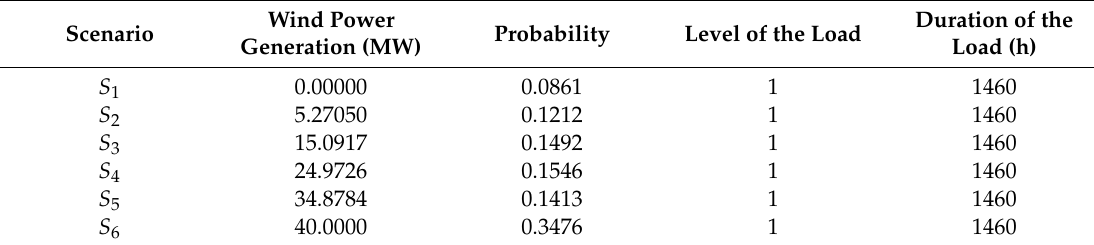
Table 12. Generated wind scenarios for the probabilistic multi-objective RPP considering the wind power generation uncertainty.